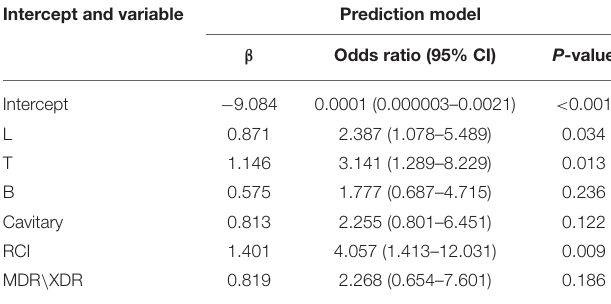
TABLE 3 | Prediction factors for postoperative complication in